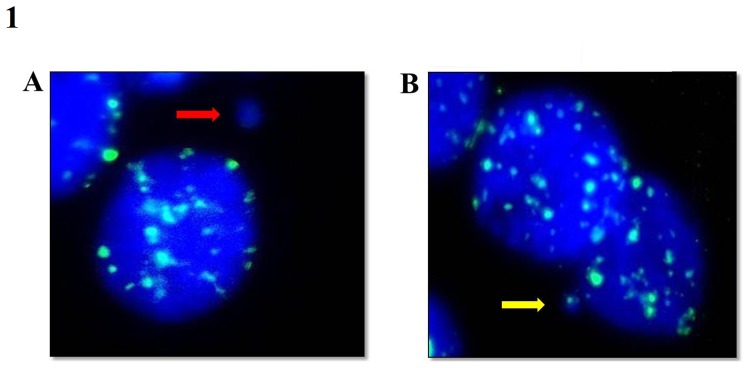
FISH-stained urothelial cells with probes for all chromosome centromeres (green spots).a) Urothelial cells counterstained with DAPI, and the red arrow indicates a micronucleus (MN) with no centromeric signal (MNC−). b) Urothelial cells counterstained with DAPI, and the yellow arrow indicates a MN with centromeric signal (MNC+). Photomicrographs were acquired at 1,000× magnification.